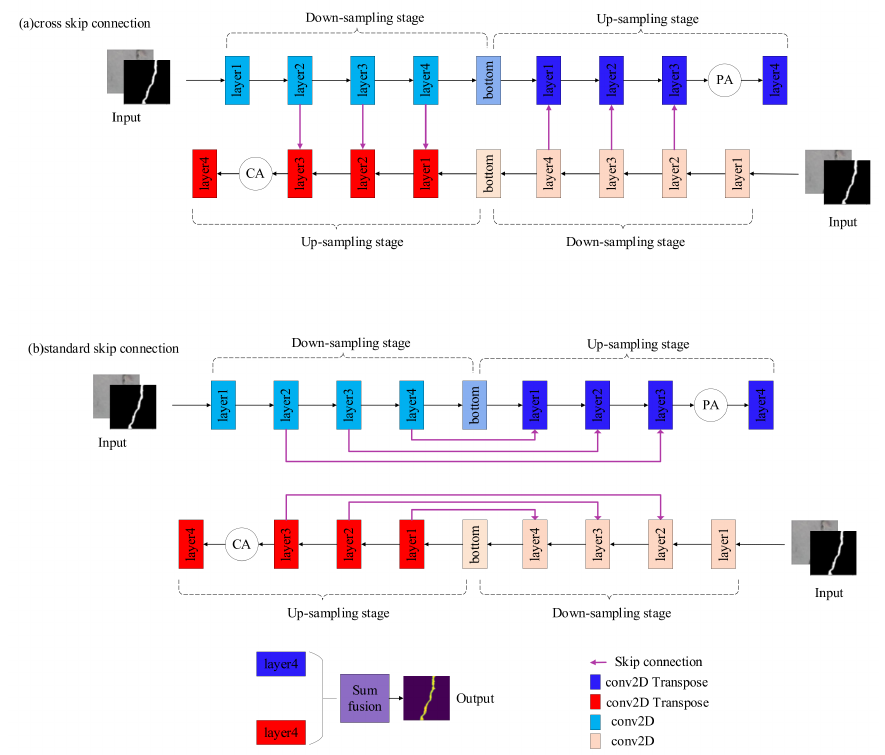
Figure 10. Two types of skip connection: ( a ) cross-skip connection; ( b ) standard skip